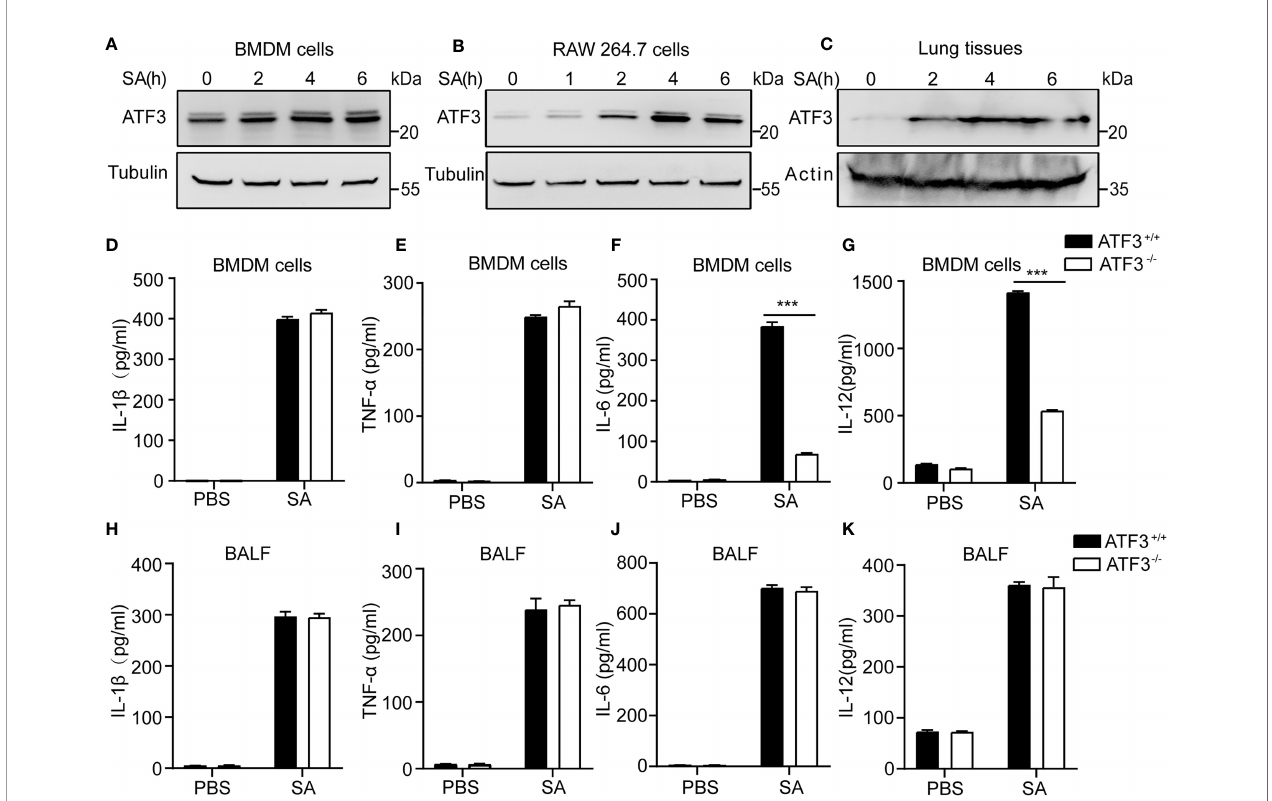
FIGURE 4 | ATF3 enhances macrophage bacterial clearance independent of M1/M2 macrophages. WT and ATF3 KO mice were challenged with 5 × 10 6 S. aureus colony forming units (CFU) and sacri fi ced 12 h later for subsequent functional analysis. (A, B) BMDM cells and RAW264.7 cells were infected with S. aureus for the indicated time periods. The cells were then lysed, and ATF3 protein levels were examined by immunoblotting. (C) Lungs obtained from S. aureus -infected mice for indicated time points were homogenized and ATF3 protein expression were measured by immunoblotting. (D – G) Macrophages derived from WT and ATF3 KO mice were infected with S. aureus for the indicated time periods, and cytokine levels in the cell supernatants were determined by ELISA. (H-K) WT and ATF3 KO mice were challenged with 5 × 10 6 CFUs of S. aureus and sacri fi ced 6 h later for the subsequent functional analysis. The levels of BALF cytokines (IL-1 b , TNF- a , IL-6, and IL-12) were detected by ELISA. *** P <